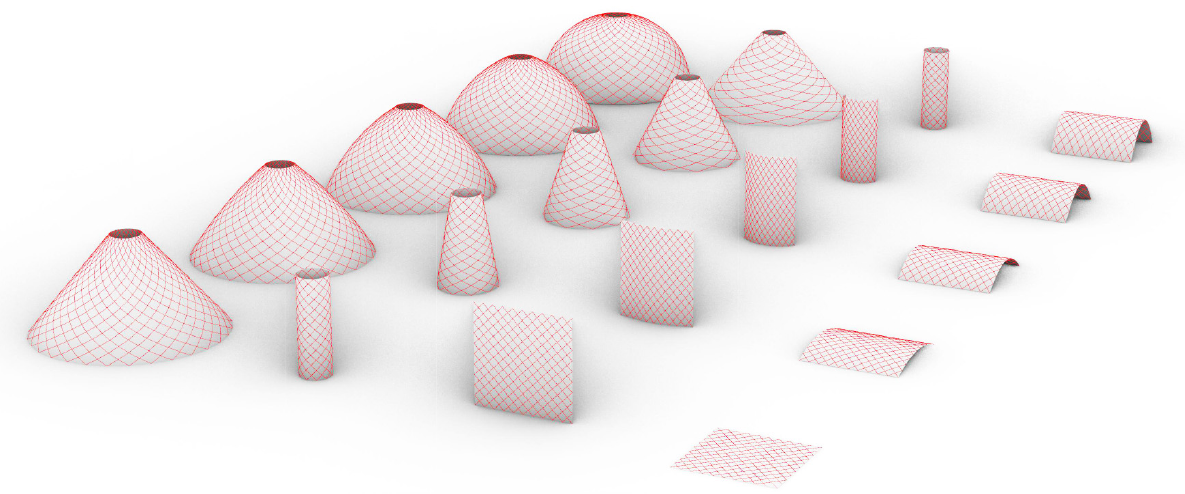
diffusion of the herringbone spiralling technique. They not